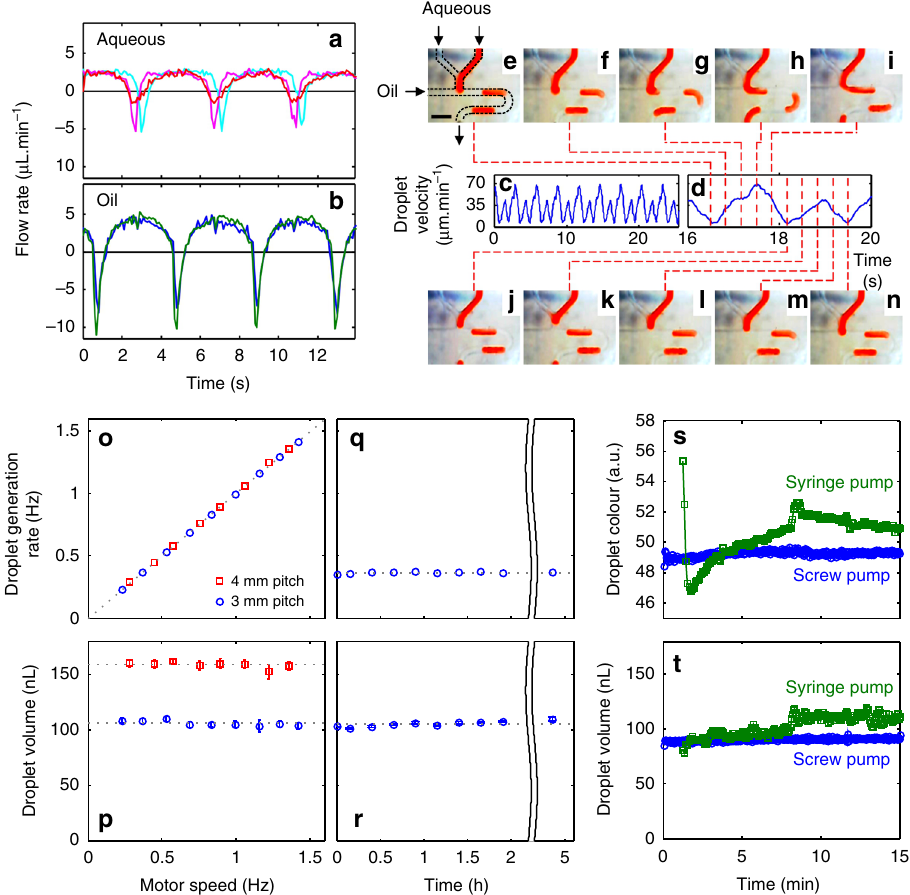
Fig. 2 Anti-phase pulsatile fl ow and its use in droplet generation. a , b Flow rate over a three-pulse period for three aqueous lines ( a ): perfusate (probe push), dialysate (probe pull) and reagent, and the two oil lines ( b ). c Downstream velocity of droplets generated by the pulsatile fl ows ( a , b ) at a T-junction. d The linear droplet velocity for a single pumping period composed of one aqueous and oil pulse. The dashed lines correlate the velocity data to droplet generation at the T-junction ( e – n ) showing the controlled generation of a single droplet in the single pumping period. Scale bar in ( e ), 1 mm. o The droplet generation rate increases linearly with motor speed (and hence fl ow rate) for both 3 mm (blue circles) and 4 mm (red squares) screw thread pitches. The points fi t on a straight line of unity gradient indicating that one droplet is produced in one turn of the pump. p Droplet volume is constant with respect to motor speed (and hence total fl ow rate) with different values for different pitch sizes. Error bars show the standard deviation in droplet size. q , r Droplet generation rate and volume remain constant when run at constant conditions (0.37 Hz, 3 mm pitch) over several hours. Error bars in ( r ) show the standard deviation in droplet size. s , t Comparison of the composition and size of droplets produced immediately after start-up using the screw-driven pump with 3 mm pitch (blue circles) and syringe pumps (green squares). The screw-driven pump instantaneously produces droplets of uniform composition ( s ) and volume ( t ), while the syringe pump shows signi fi cant drift over